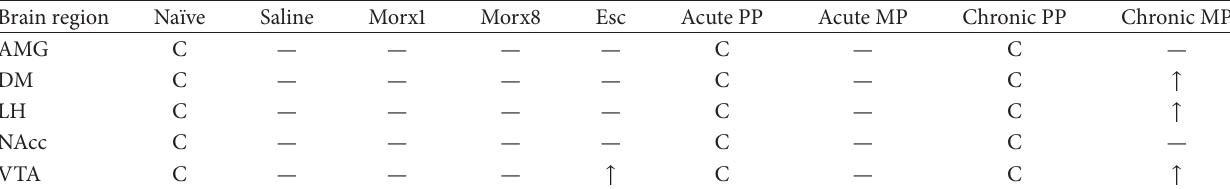
Table 2: Summary of changes in CREB phosphorylation in different brain regions following morphine treatment. Brain